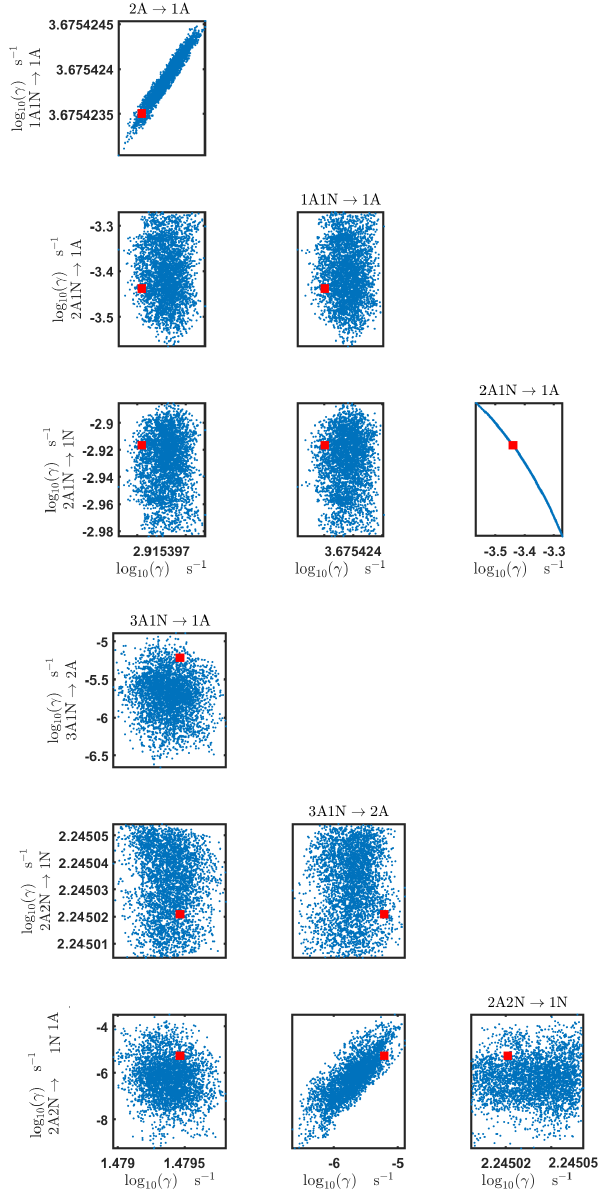
Figure C5. Pairwise marginal posterior distributions (for parameter indexes ranging from 9 to 16) of the base 10 logarithm of the evap- oration rates (units given in s − 1 ) determined from time-dependent measurements of the cluster concentrations with time resolution comprising 1.5min at the temperature 278K. Red rectangles denote the baseline values from Olenius et al. (2013b) used to generate the synthetic data. The notation xAyN corresponds to a cluster with x sulfuric acid and y ammonia